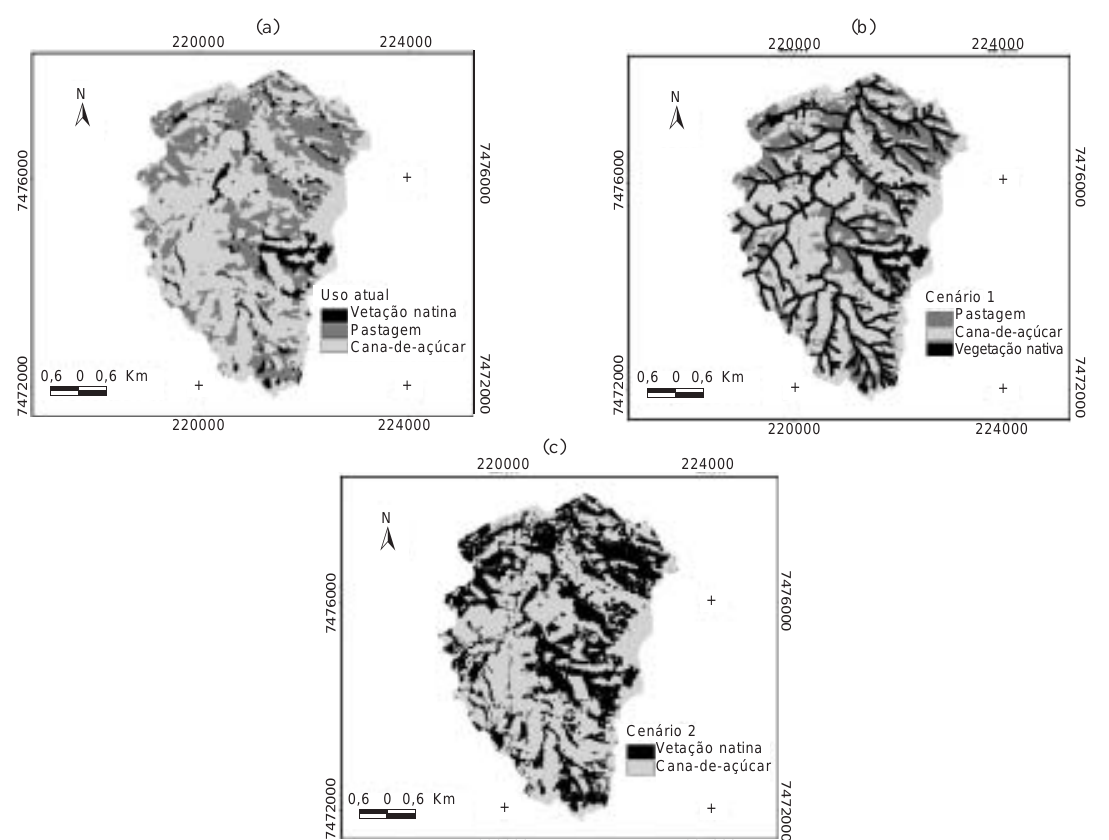
Figura 2. Uso da terra na microbacia do Ribeirão dos Marins para o uso atual e para os dois cenários